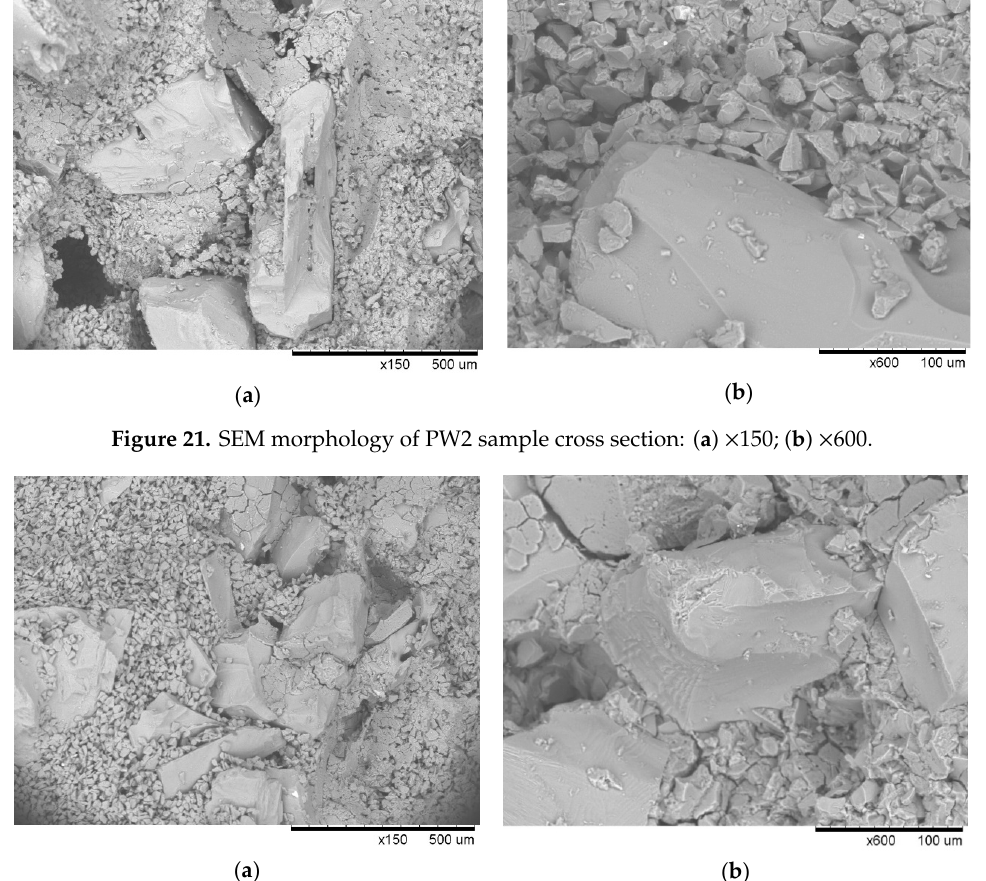
Figure 20. SEM morphology of PW1 sample cross section: ( a ) ×150; ( b ) ×600.